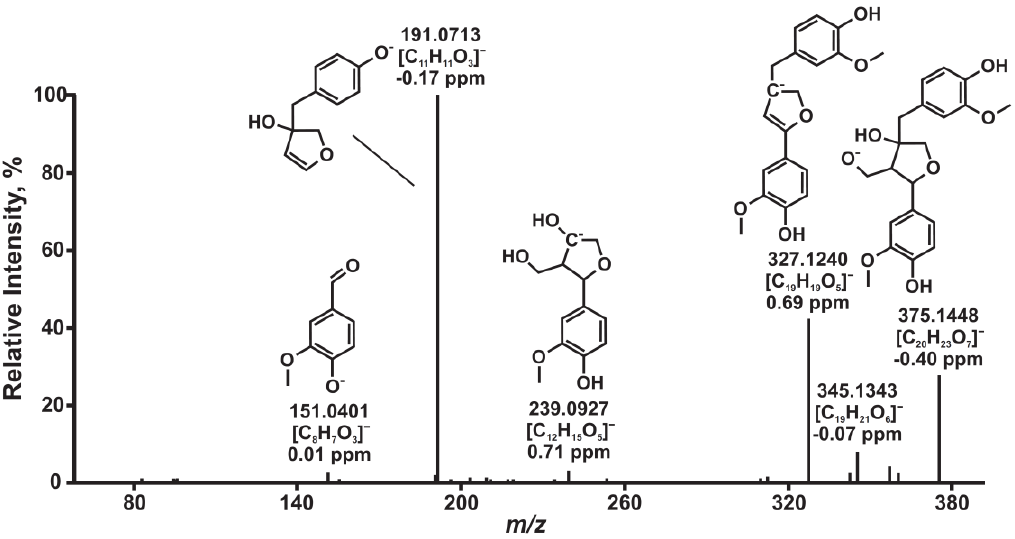
Figure 4. Tandem mass spectrum of the lignan C 20 H 24 O 7 identified as olivil.